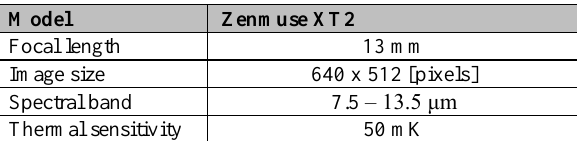
Table 5. Main specifications of Zenmuse XT2 thermal camera.